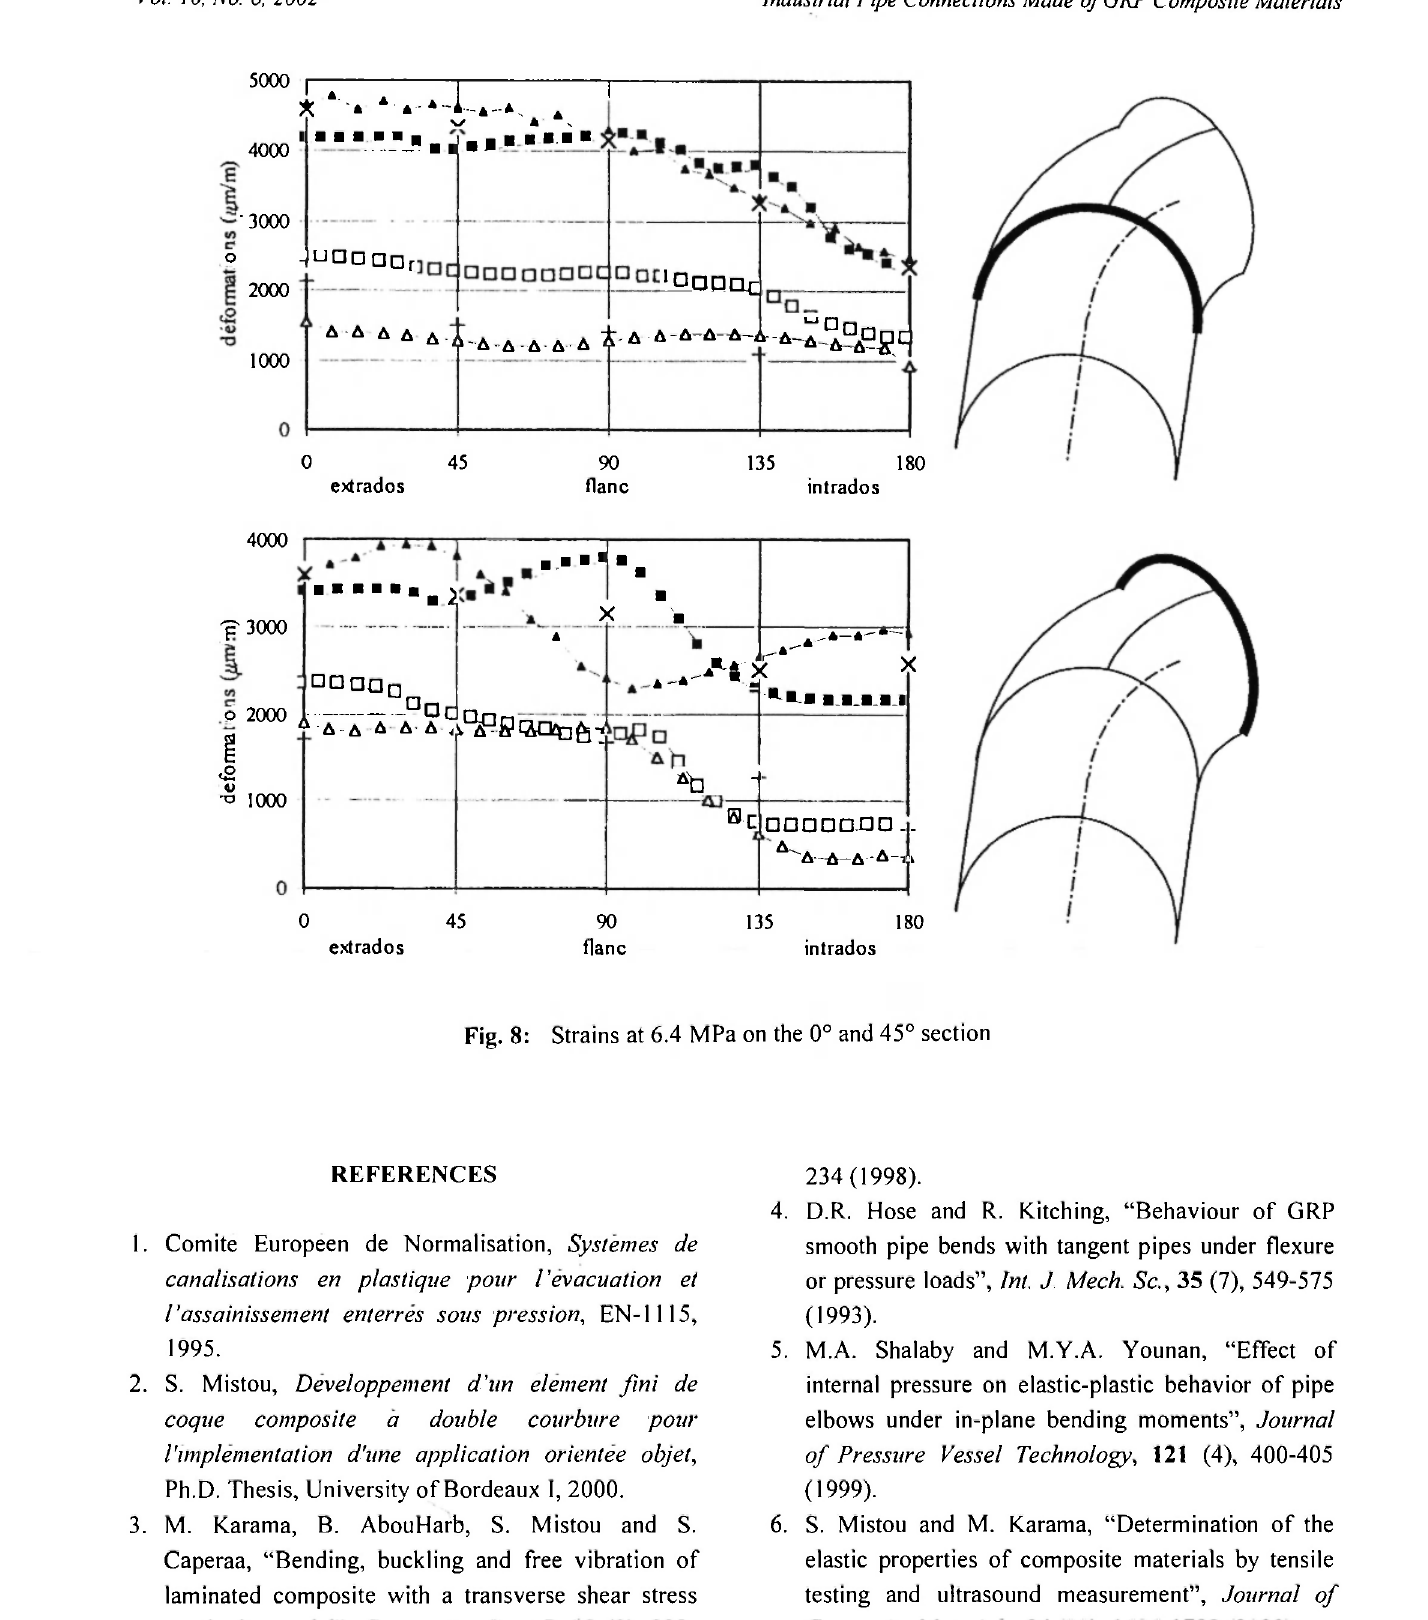
Fig. 8: Strains at 6.4 MPa on the 0° and 45°